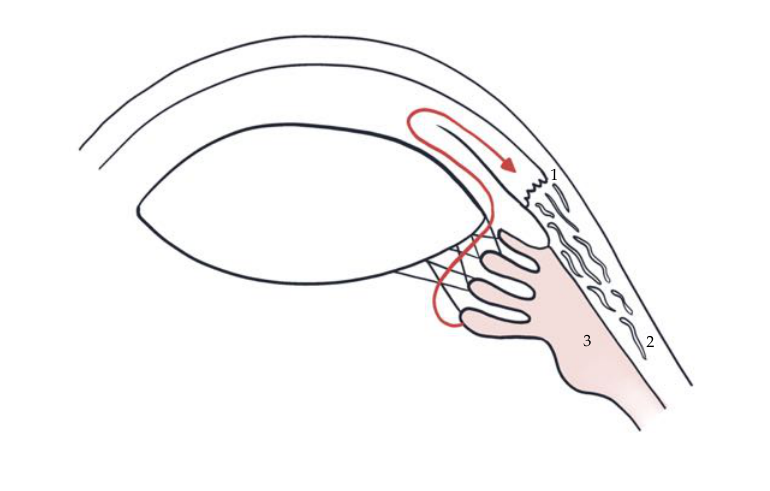
Figure 1. Aqueous humor drainage routes in canine eye. After being produced at the level of the ciliary processes, the aqueous humor flows through the posterior chamber into the anterior chamber (dorso-ventral direction, via convection currents). Here, it is drained via the trabecular meshwork of the ciliary cleft and into the angular aqueous plexus then directed anteriorly into the episcleral venules (1) or posteriorly into the scleral venous plexus and the vortex venous system (2). An alternative aqueous humor drainage pathway (3) is the diffusion through the ciliary muscle interstitium to the suprachoroidal space and through the sclera (ie, uveoscleral outflow).